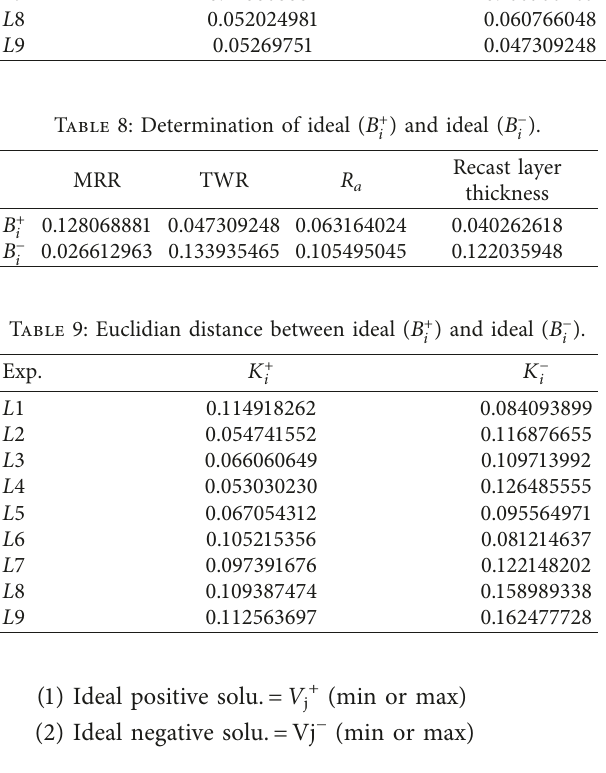
Table 10: Relative performance closeness.